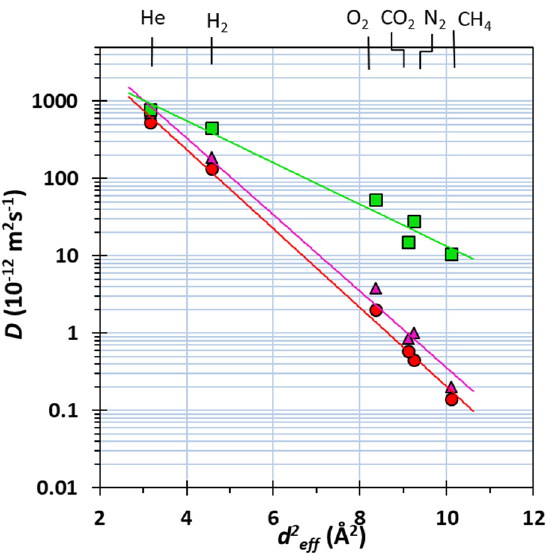
Figure 8. Correlation of the effective diffusion coefficient of six light gases as a function of their molecular diameter, as defined by Teplyakov and Meares [50], for the PEEK–WC • , PEEK–WC/ m -xy ▲ , and PEEK–WC/Fura ■ membranes.